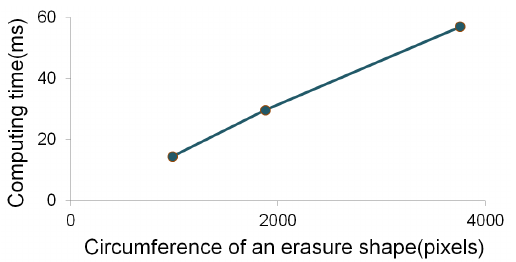
Figure 11. The relationship between the circumference of the erasure shape and the total data preprocessing